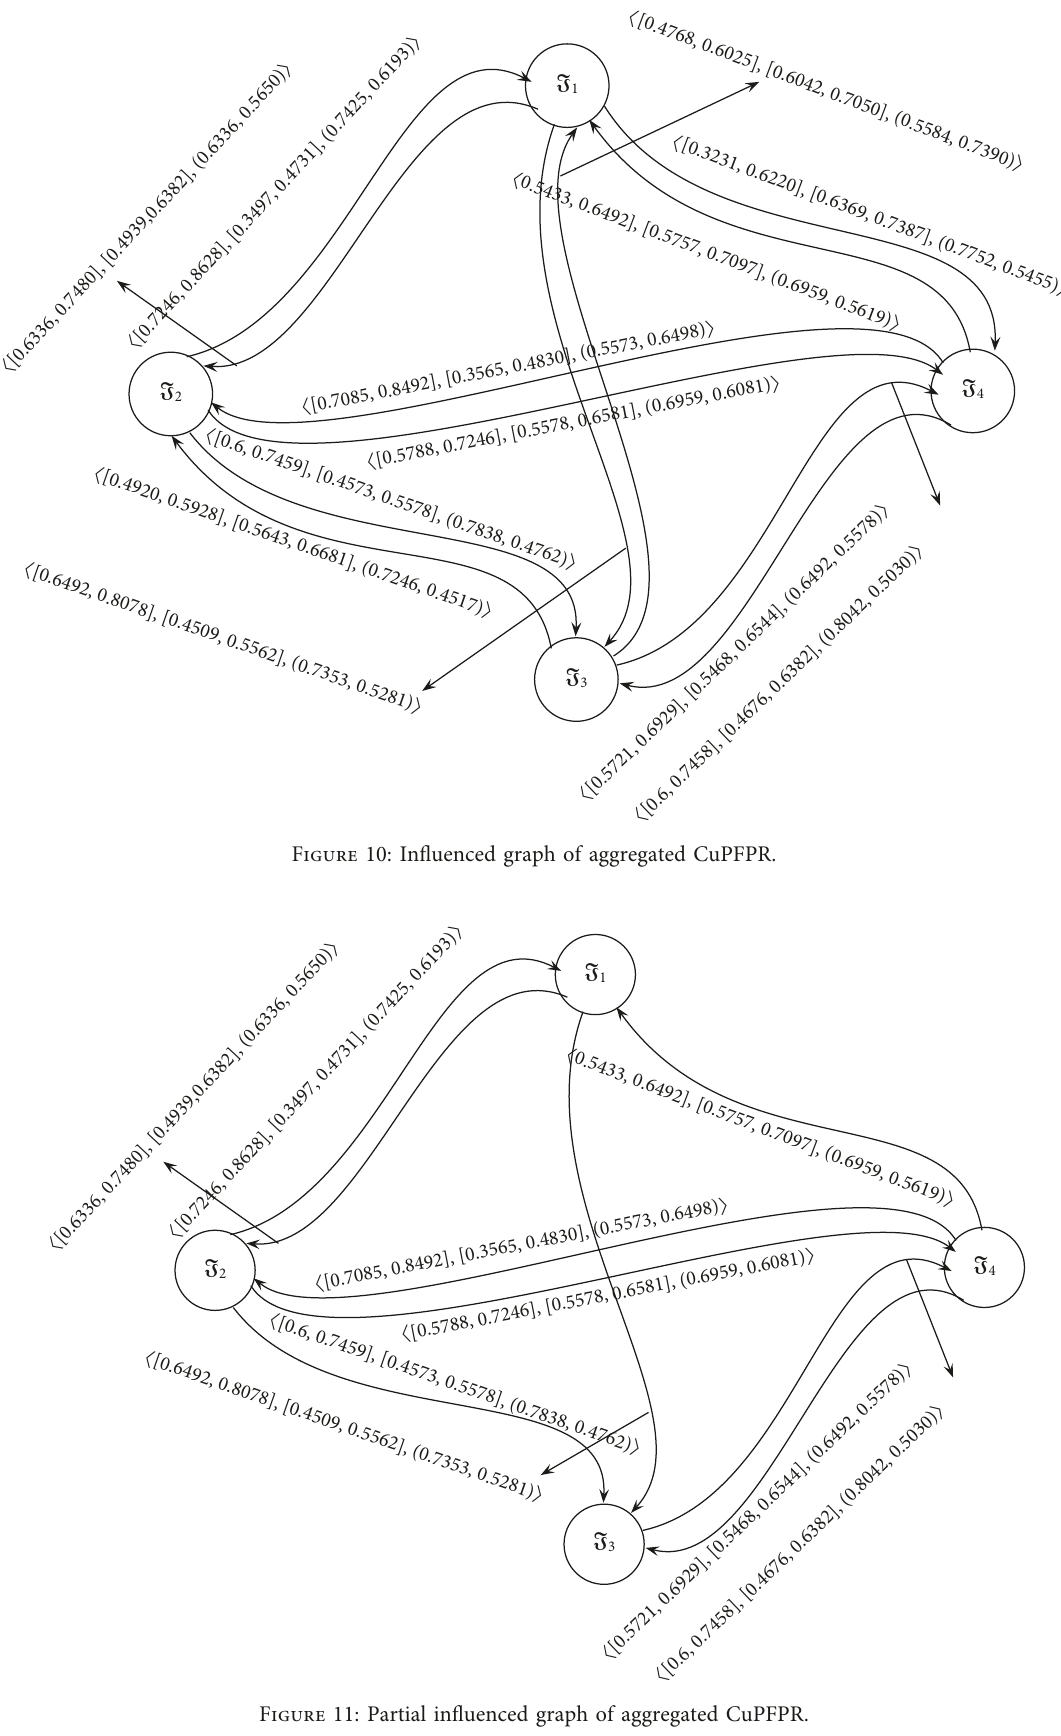
Figure 11: Partial influenced graph of aggregated